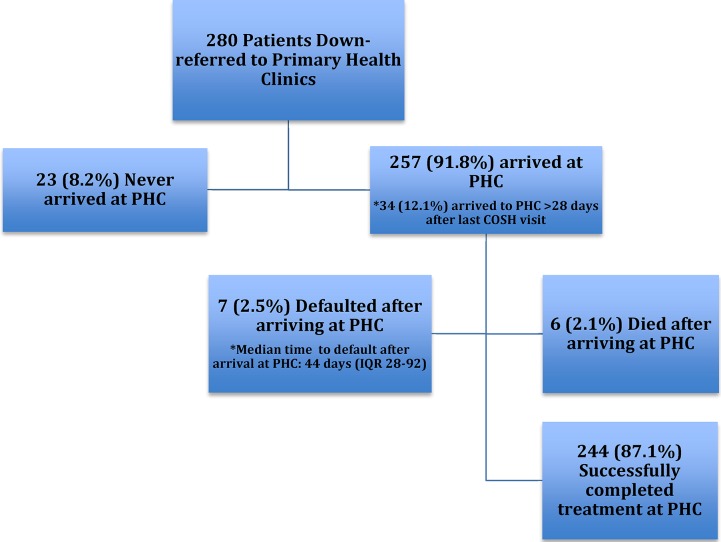
Timing of default in down-referred cohort.Of 280 patients who were down-referred from the district hospital clinic to primary health clinics (PHCs) for completion of tuberculosis (TB) treatment, 23 (8.2%) never arrived at a PHC. Of those that did successfully link to a PHC, 34 (12.1%) arrived late and thus missed doses of TB medication; 7 (2.5%) defaulted before completing TB treatment; 6 (2.1%) died while on TB treatment; and 244 (87.1%) successfully completed treatment at the PHC.